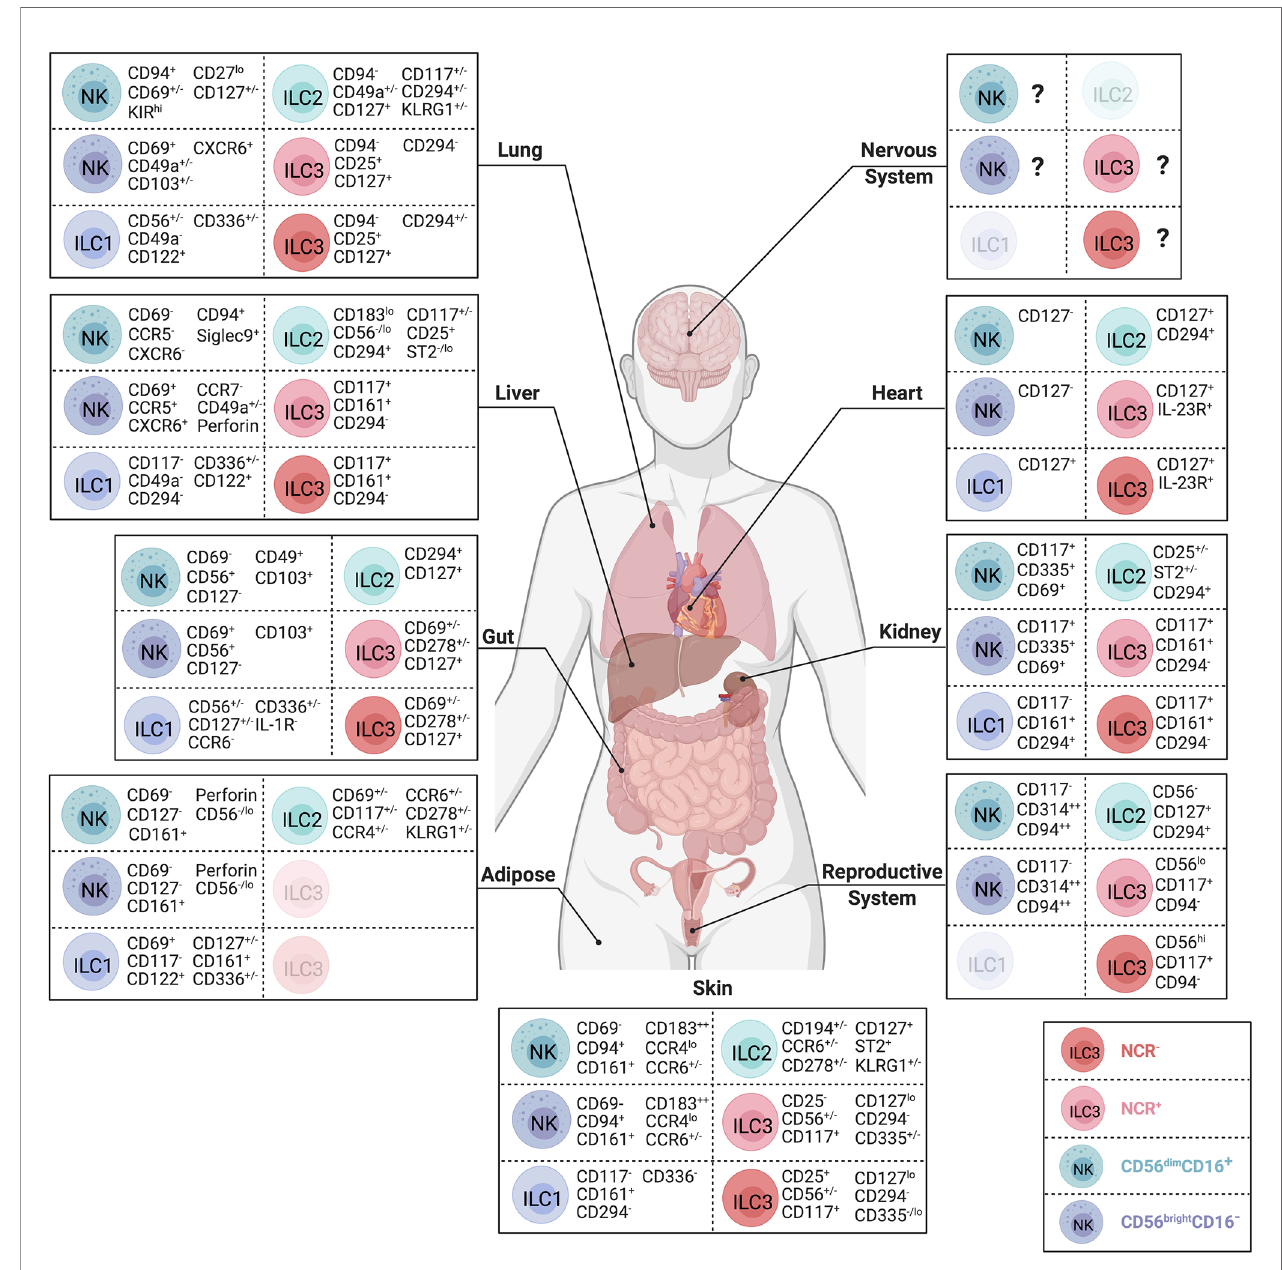
FIGURE 2 | Body-wide distribution and surface phenotypes of human ILCs. Surface marker expression of CD56 dim NK cells (teal), CD56 bright NK cells (dark blue), ILC1s (purple), ILC2s (green), NCR - ILC3s (red) and NCR + ILC3s (pink) in nervous system, lung, heart, liver, kidney, gut, reproductive system, adipose tissue, and skin. ILC subsets that have not yet been identi fi ed during steady state visualized in lighter color. Represented selection of ILC markers is based on the consistent use of these markers across multiple independent studies. Created with